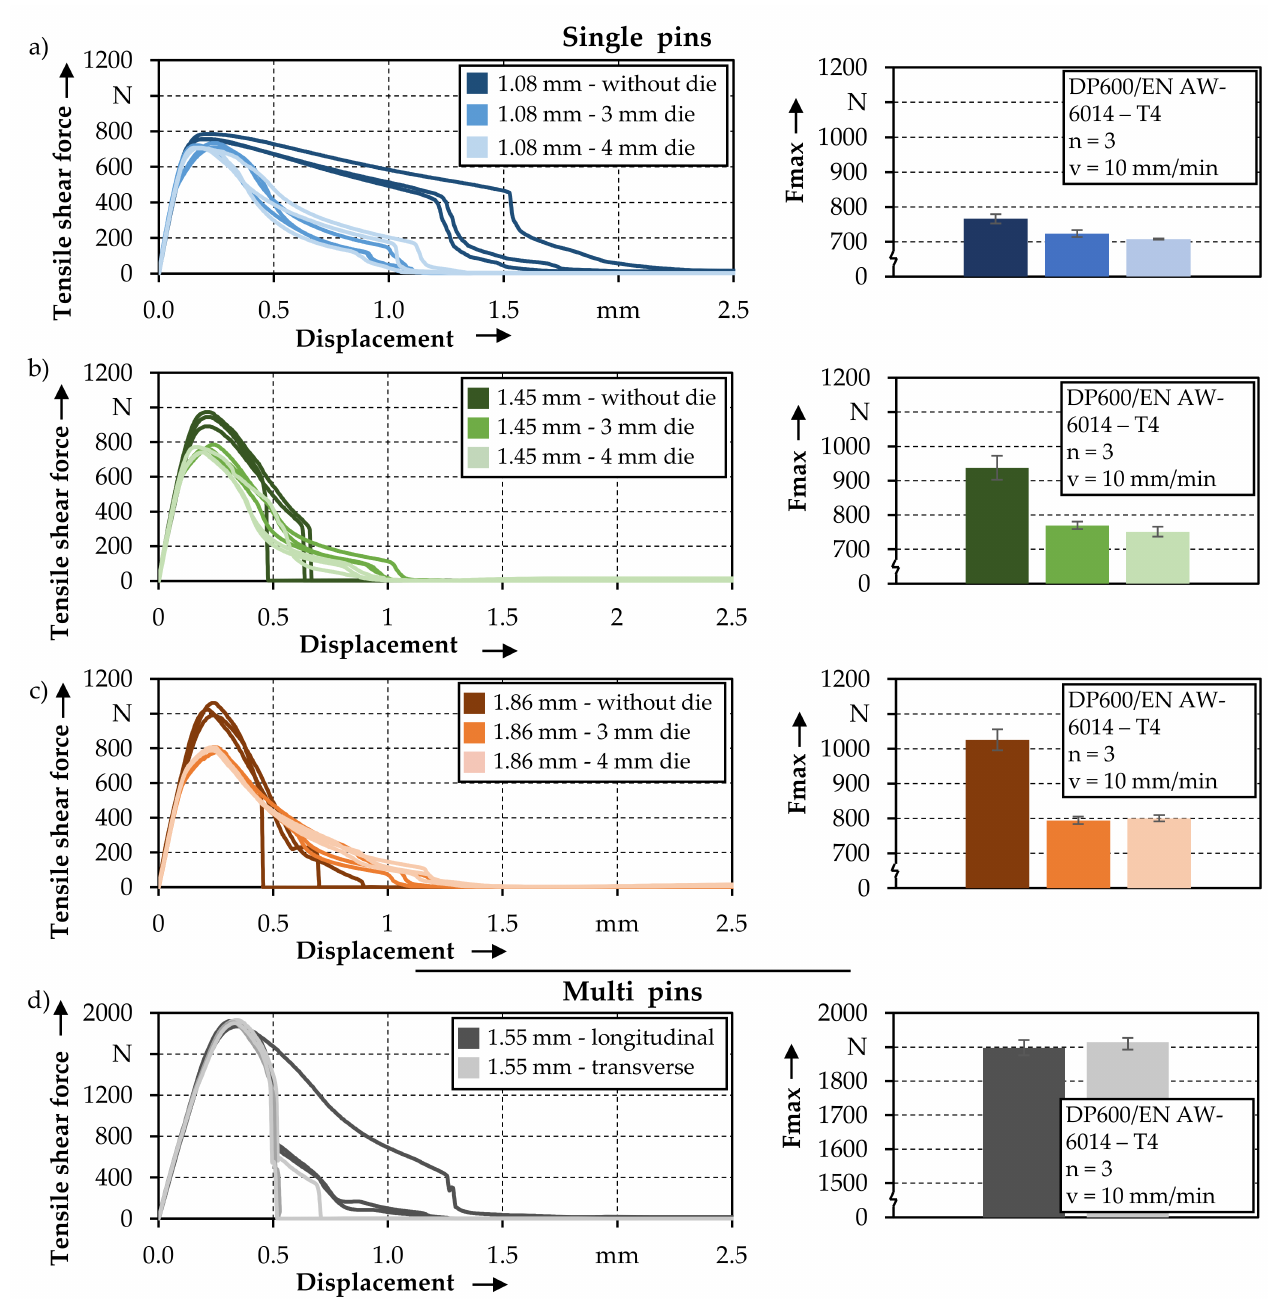
Figure 11. Tensile shear force–displacement curves of the investigated pin-height/joining strategy combination as well as multi pin joints. ( a ) Tensile shear force-displacement curves with corresponding maximum force for 1.08 mm single pins joined without and with die, ( b ) tensile shear force-displacement curves with corresponding maximum force for 1.45 mm single pins joined without and with die, ( c ) tensile shear force-displacement curves with corresponding maximum force for 1.86 mm single pins joined without and with die and ( d ) tensile shear force-displacement curves with corresponding maximum force for 1.55 mm multi